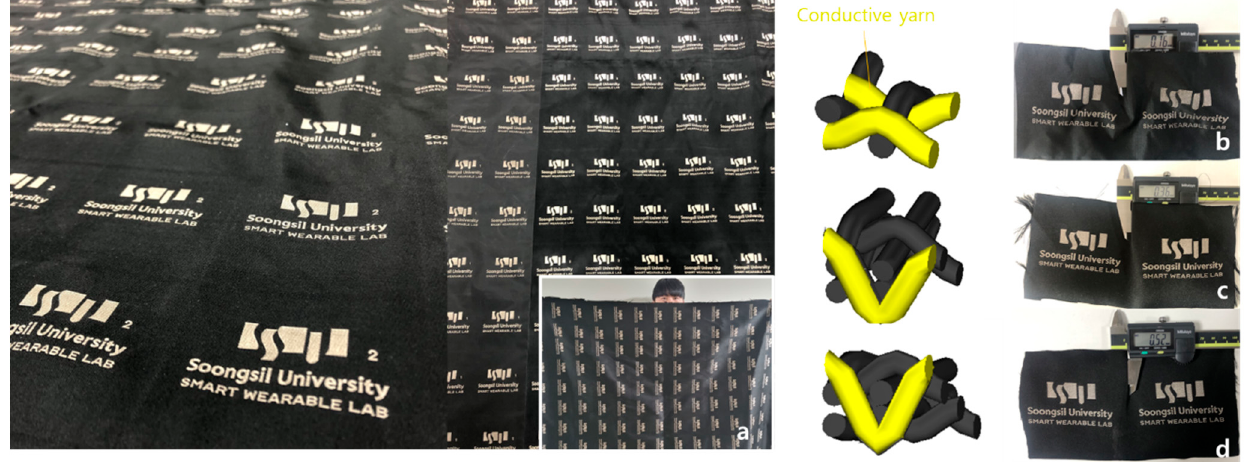
Figure 2. ( a ) Large-area piezoresistive textile pressure sensor, ( b ) single layer with thickness 0.16 mm, ( c ) double layer with thickness 0.36 mm, ( d ) quadruple layer with thickness 0.52 mm. The gray yarns are the non-conductive or regular yarn, and the yellow threads